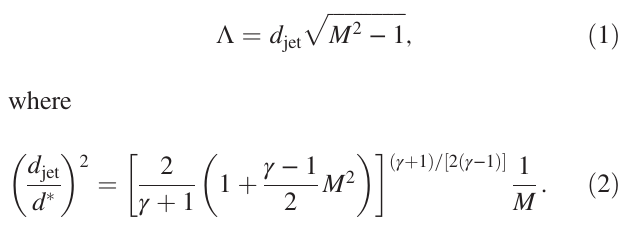
¼ 10 . 8 mm. (b) Nozzle 2: exit